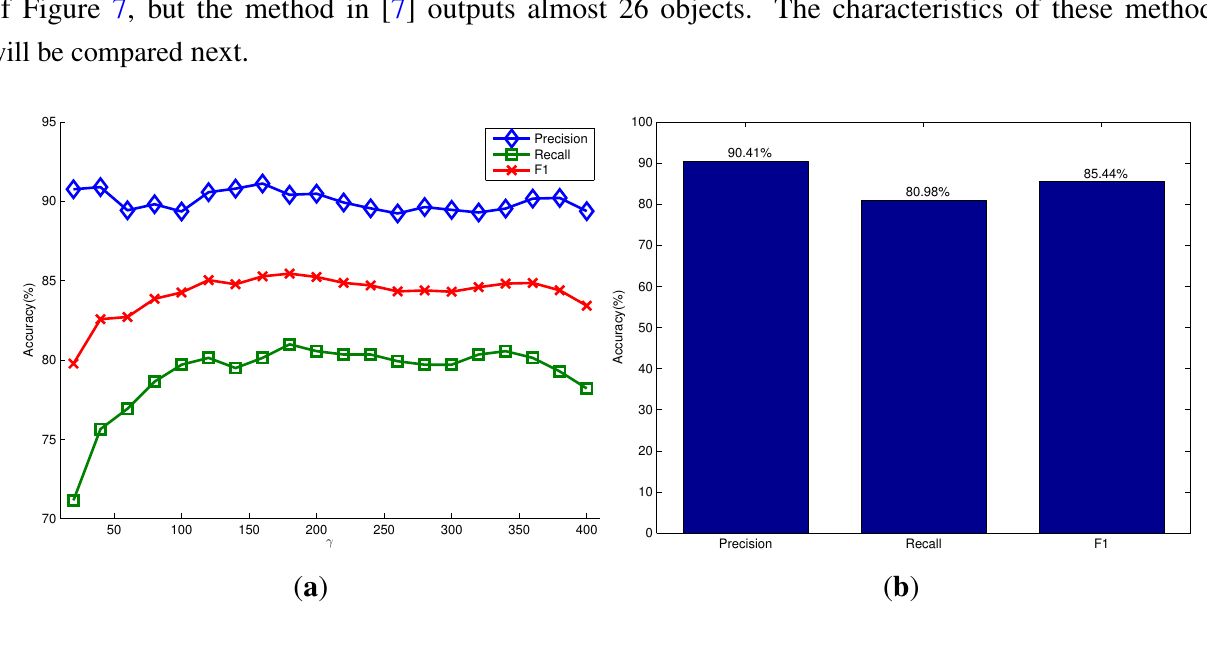
Figure 6. Quantitative evaluation on the OSD dataset. ( a ) The precision, recall and F1-measure scores versus the parameter γ in the model of the object hypothesis, respectively; ( b ) the corresponding scores when using γ = 180